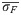
Features of the classification dataset.In all subfigures, each circle represents an acoustic component of the classification dataset. Subfigures A and B show the duration (D), mean frequency (FMean), and intensity (I) of CAS and non-CAS components, respectively. Subfigures C and D show the standard deviation frequency (σF), mean point-by-point σF (σF¯), and type of analysis area of CAS and non-CAS components, respectively.